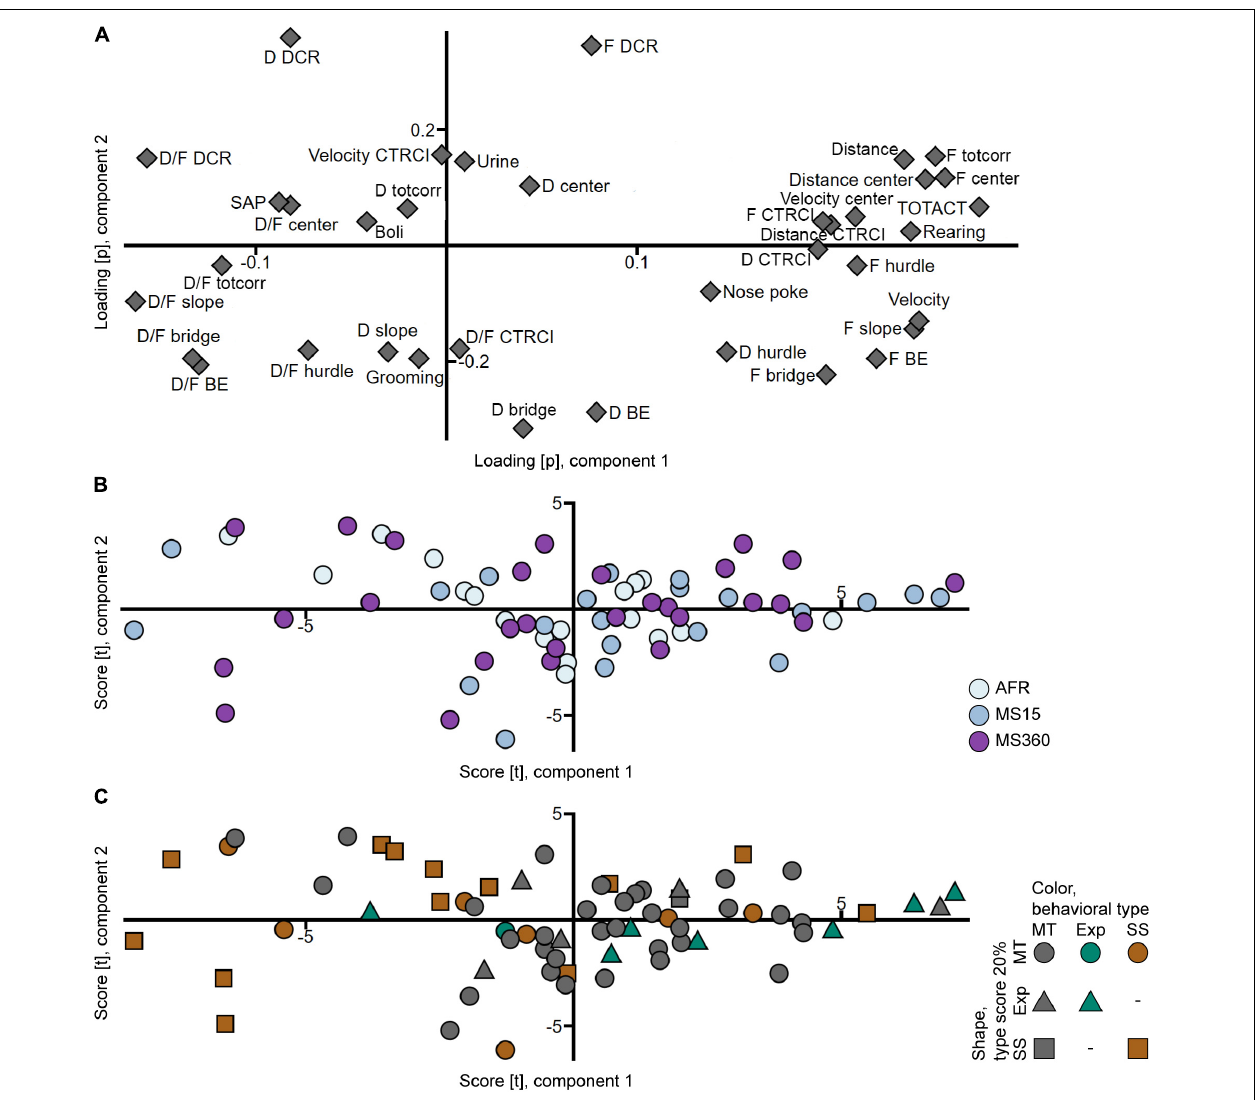
FIGURE 4 | Scatter plots of the (A) parameter loadings and (B,C) individual scores from the adult PCA ( n = 67, two components, R 2 X = 0.447, Q 2 = 0.290). (B) is colored according to rearing condition and (C) according to behavioral type, and the shapes show the top 20% of each type score (exploration and shelter seeking). AFR, animal facility reared; BE, bridge entrance; CTRCI, central circle; D, duration; DCR, dark corner room; D/F, duration per visit; Exp, Explorer/exploration; F, frequency; MS15, maternal separation 15 min; MS360, maternal separation 360 min; MT, Main type; SAP, stretched attend posture; SS, Shelter seeker/seeking; TOTACT, total activity; totcorr, total